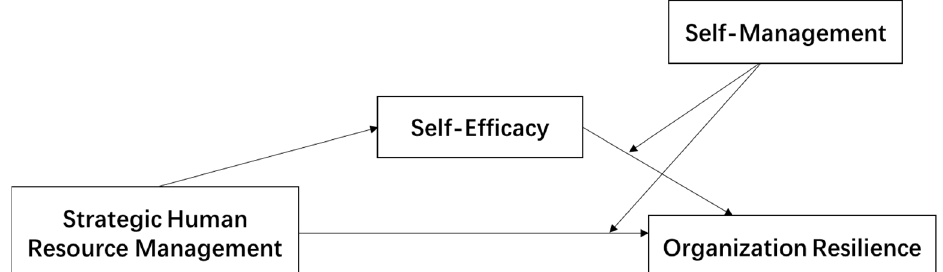
Figure 1. Hypothetical model of the mediating effect of self ‐ efficacy and the moderating effect of self ‐ management.